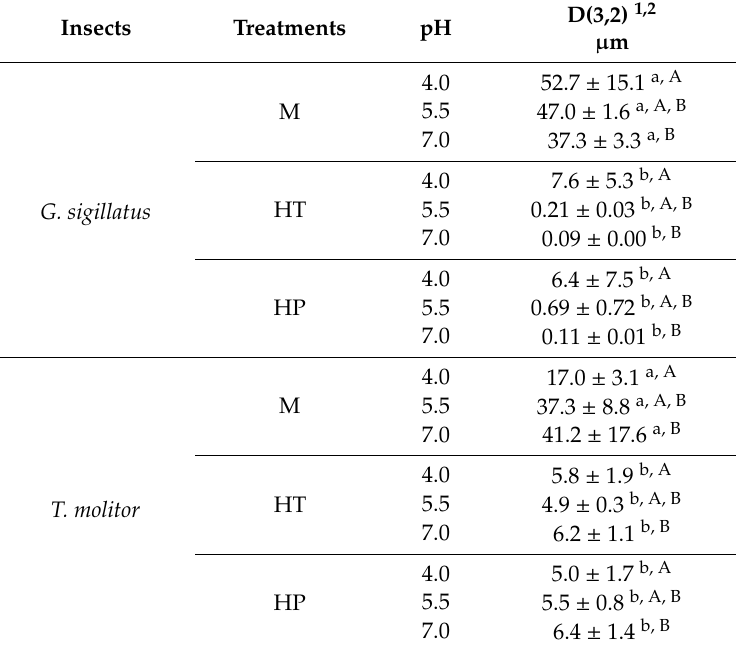
Table 2. Particle size distribution indexes of cricket and mealworm meals and hydrolysates generated with or without HHP pretreatment of